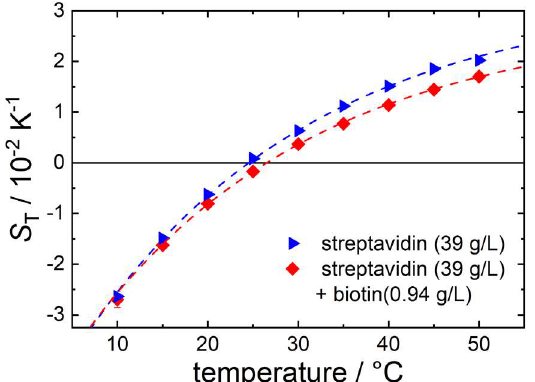
Fig. 5. The Soret coefficient 𝑆 (cid:3021) shows that the free STV is more hydrophilic than the STV+B complex. This indicates that the entropy of the hydration layer increases upon complex